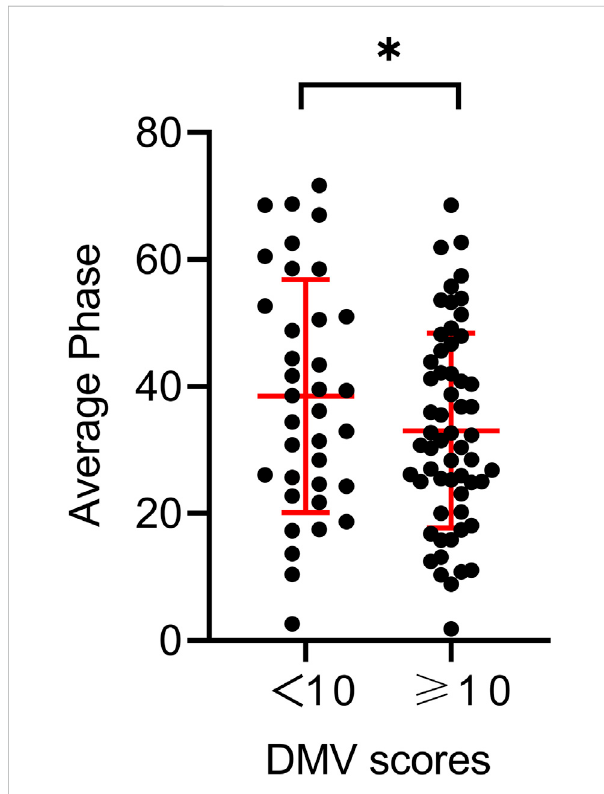
FIGURE 3 Comparison of the average phase between different DMV score groups. * p <